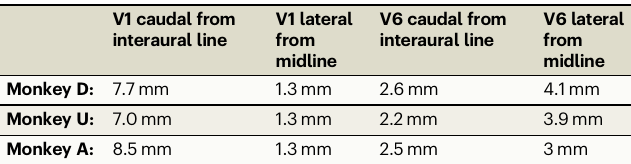
Table 2 | Coordinates of implantation